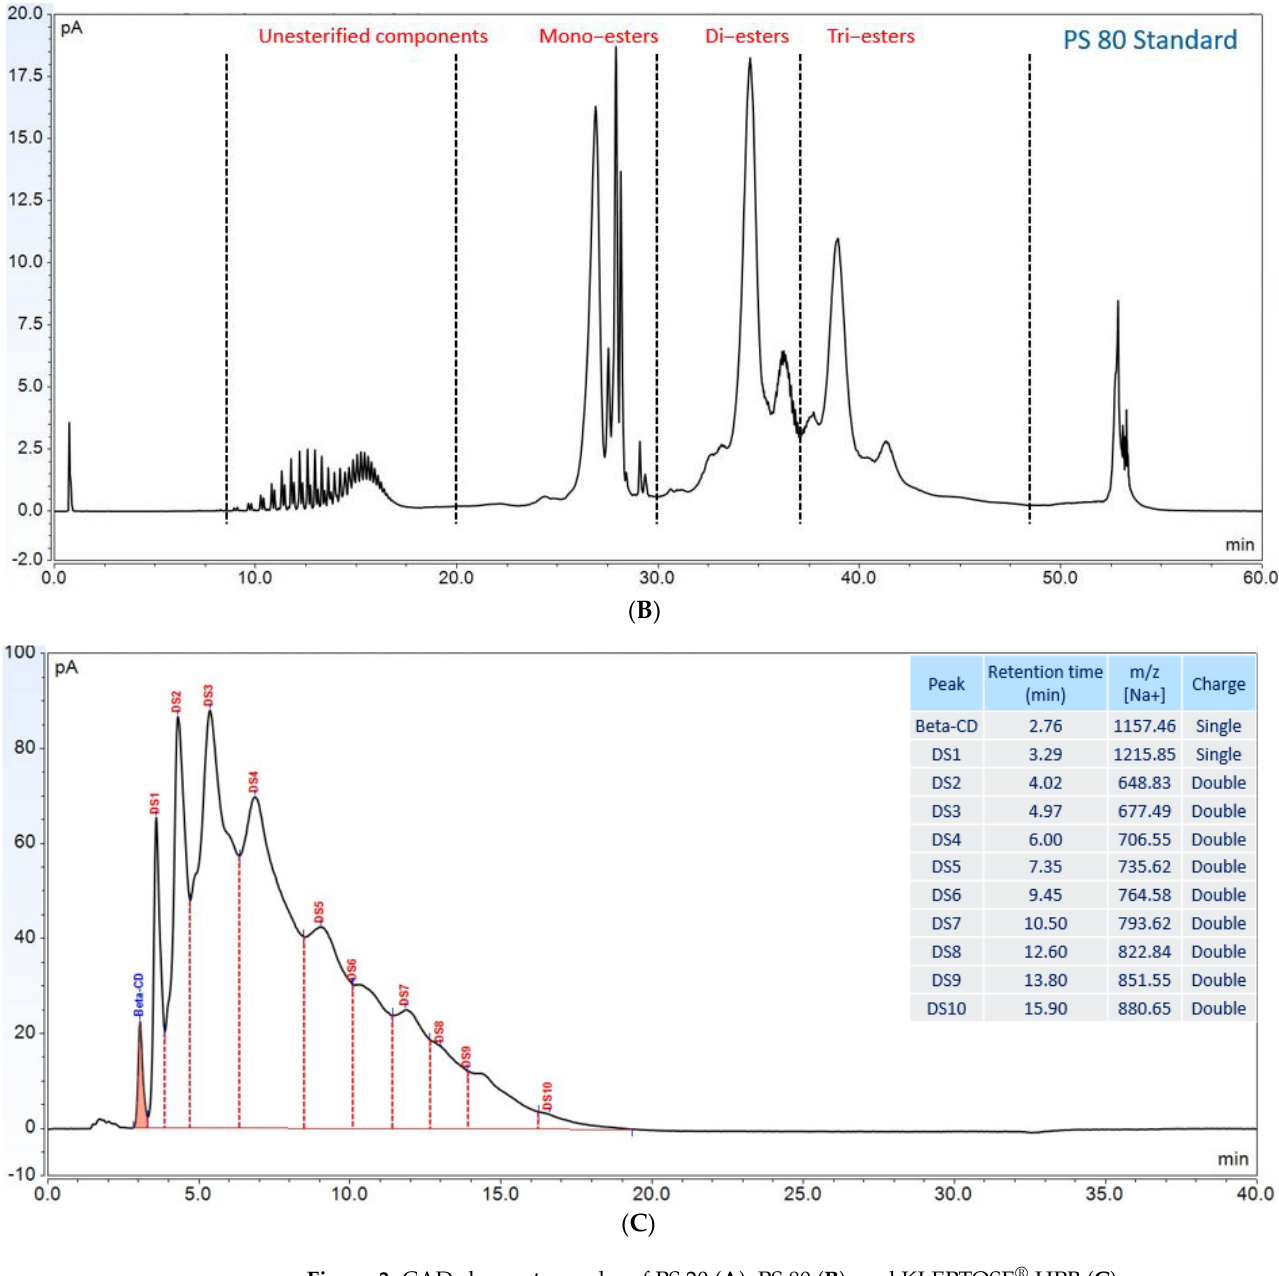
Figure 3. CAD chromatography of PS 20 ( A ), PS 80 ( B ), and KLEPTOSE ® HPB ( C ). Table 2. LC/ESI–MS identification results of PS 20, PS 80, and